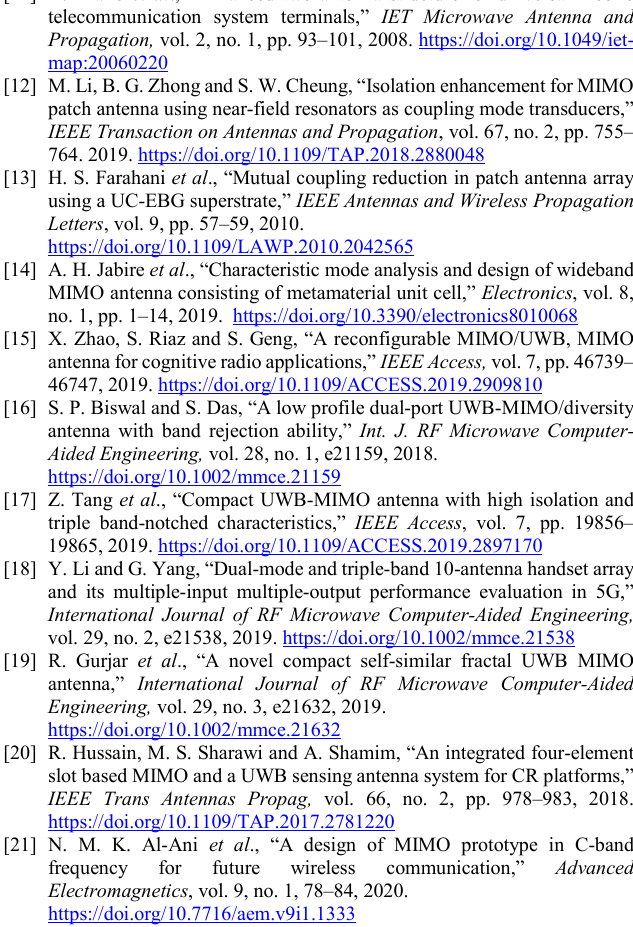
P ERFORMANCE C OMPARISON WITH O THER A NTENNAS P RESENTED IN THE